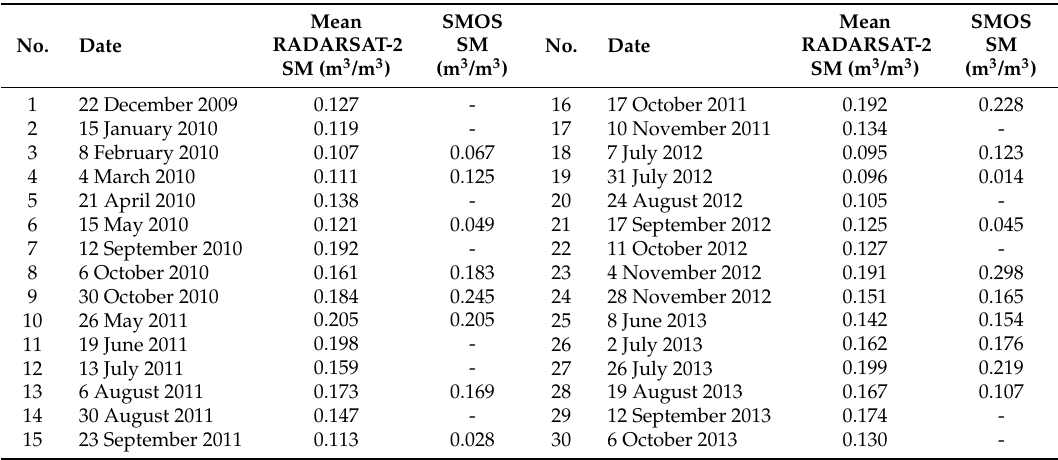
Table 1. Details of the used RADARSAT-2 and SMOS soil moisture products. The up-scaled RADARSAT-2 SM is at a spatial resolution of 25